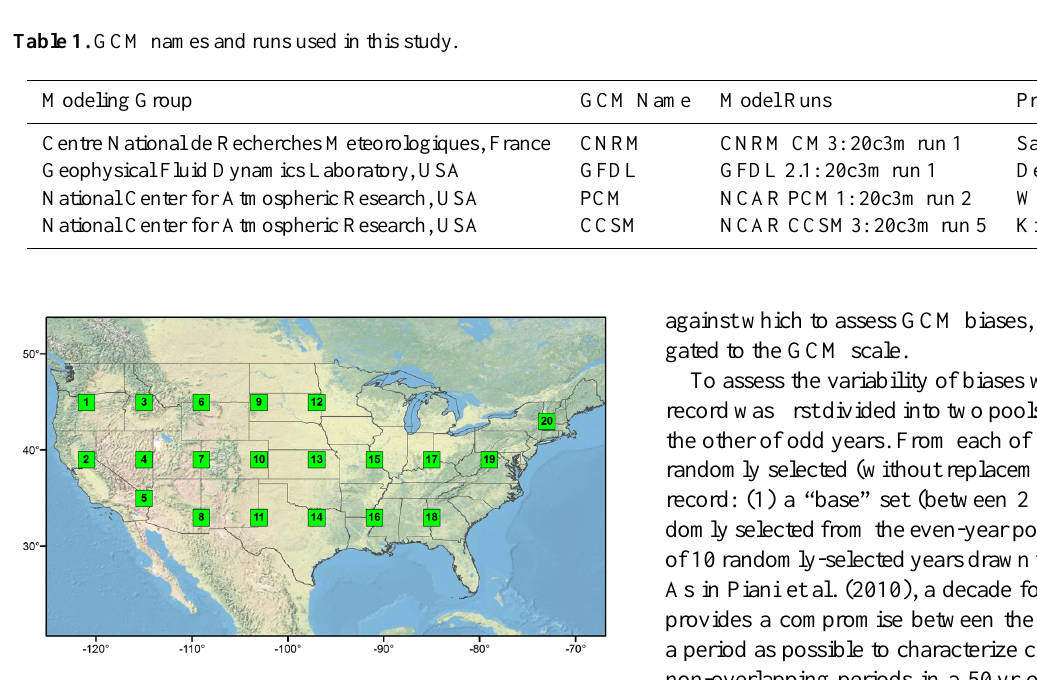
Fig. 1. Location of the 20 grid cells used in this